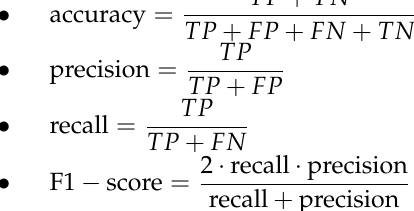
Table 5. Details of the ISCXIDS2012 dataset.